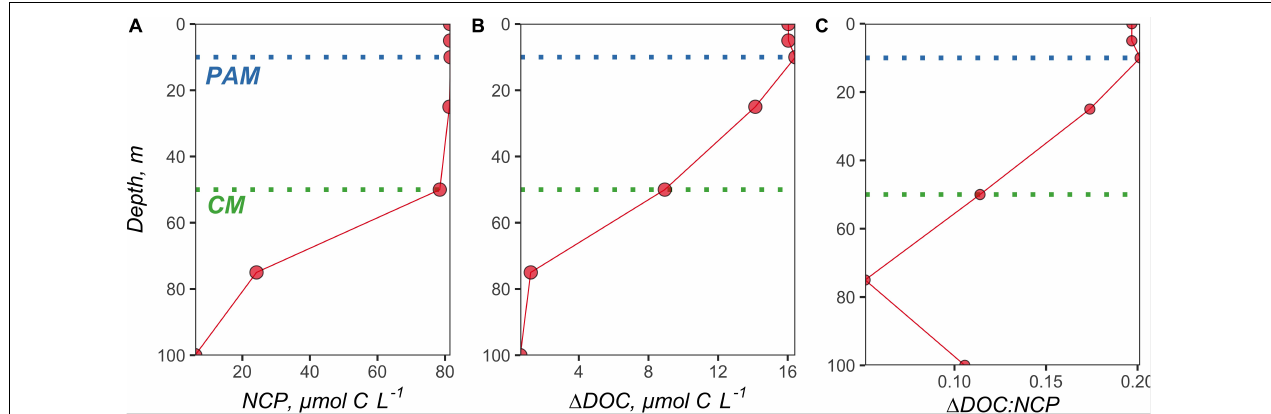
FIGURE 4 | Vertical profiles of volumetrically estimated (A) NCP (difference between NO 3 Mixed and NO 3 Observed at each depth × 6.6), (B) (cid:49) DOC (difference between DOC Observed and DOC Mixed at each depth), and (C) subsequent (cid:49) DOC:NCP . The NO 3 and DOC profiles used to make these estimates were taken from station 5 at 51.7 ◦ N and − 39.5 ◦ W. The green dotted line denotes the chlorophyll maximum ( CM ), and the blue dotted line demarcates the phytoplankton abundance maximum ( PAM